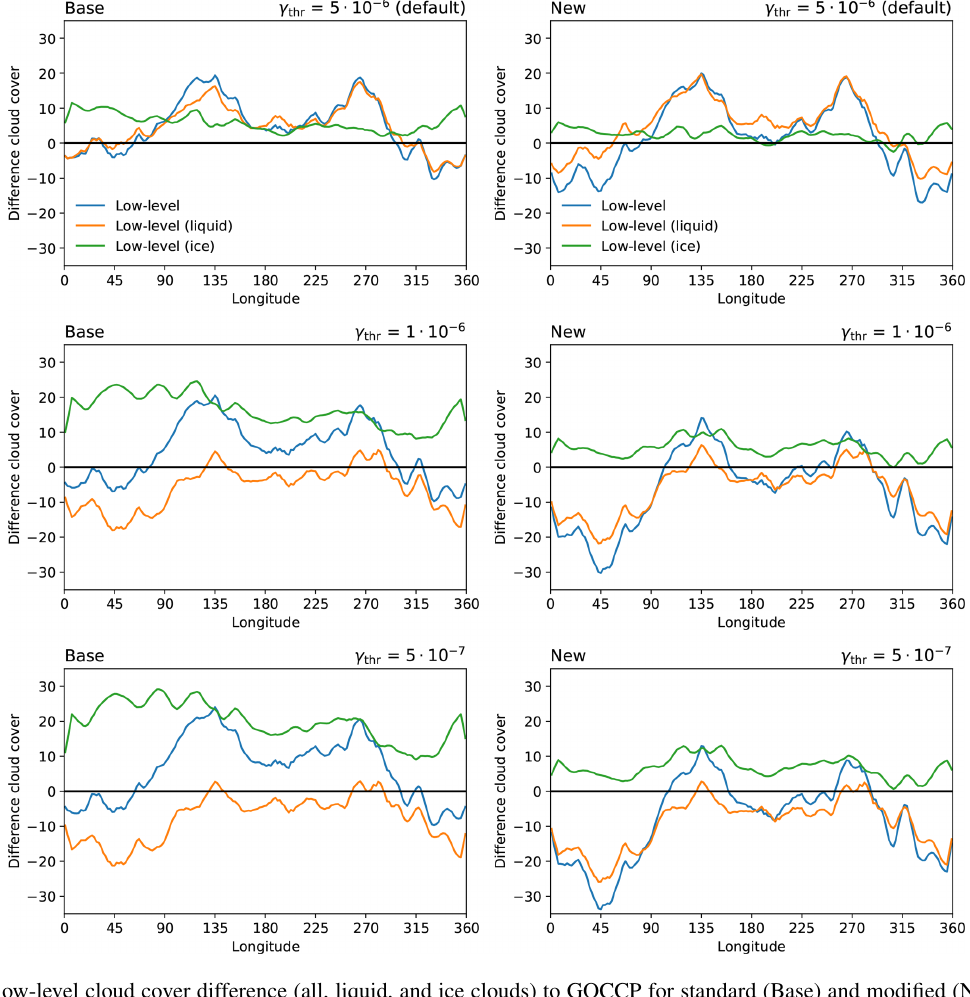
Figure 6. DJF low-level cloud cover difference (all, liquid, and ice clouds) to GOCCP for standard (Base) and modified (New) calculation of saturation water vapor pressure in the cloud cover scheme for different values of γ thr (unit of γ thr is kgm − 3